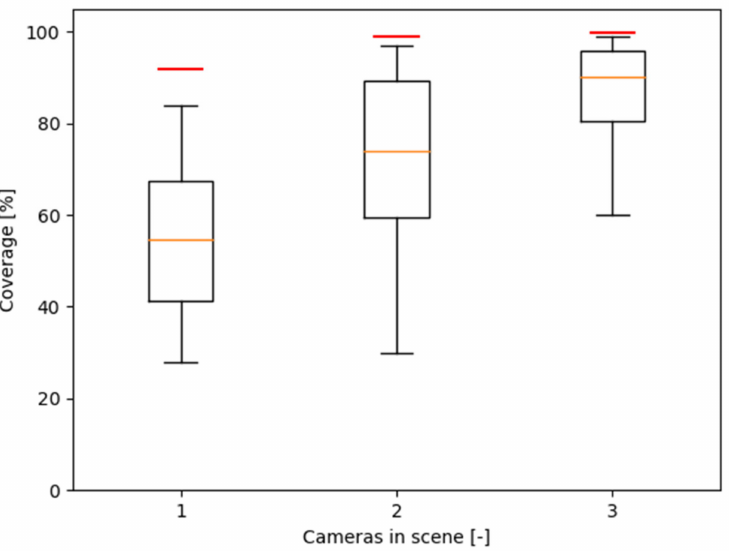
Figure 17. Statistical distribution of relative camera coverage for the camera(s) placed by the human subjects (boxplots), and the relative coverage of the calculated optimal camera(s) (red lines). As can be seen, with increasing the number of cameras, the subjects were getting closer to the calculation, but the calculated positions were always better. While the average coverage achieved by the subjects was 55.0% for one camera, 72.3% for two cameras, and 87.1% for three cameras, the coverage of the calculated cameras was 91.9% for one camera, 98.8% for two cameras, and 99.8% for three cameras in the